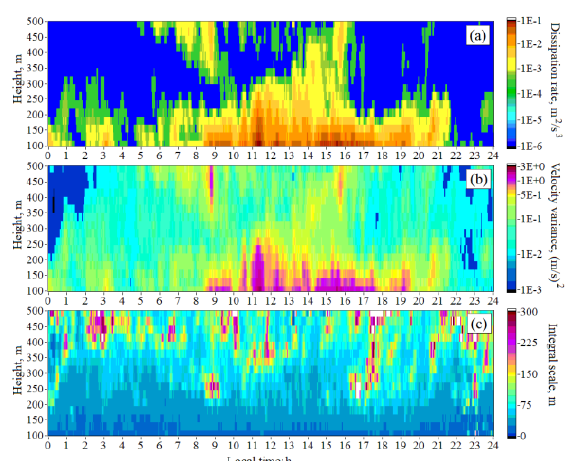
Figure 2 – Height-time distribution of the dissipation rate of turbulence energy (a), variance of the radial wind velocity (b) and the integral scale of turbulence (c) obtained from measurements by the Stream Line lidar on August 21 of